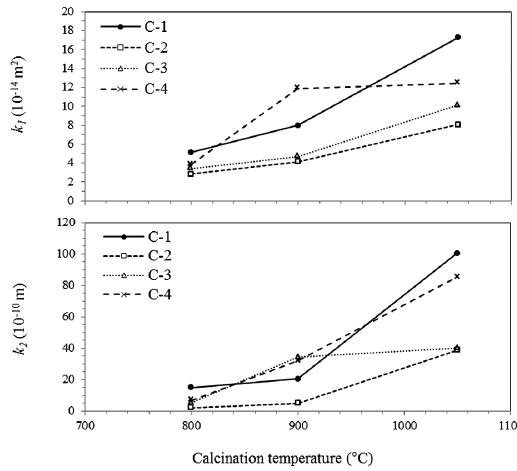
Figure 6. Influence of the heat-treatment temperature on the permeability coefficients k